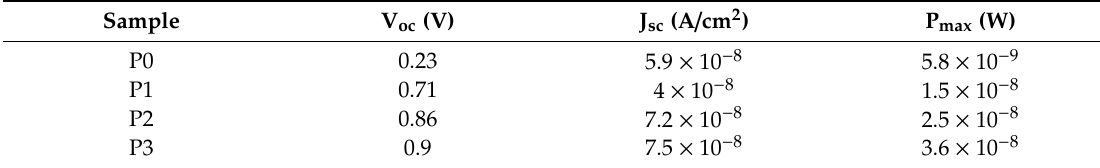
Table 1. Electrical parameters of the MAPLE-deposited